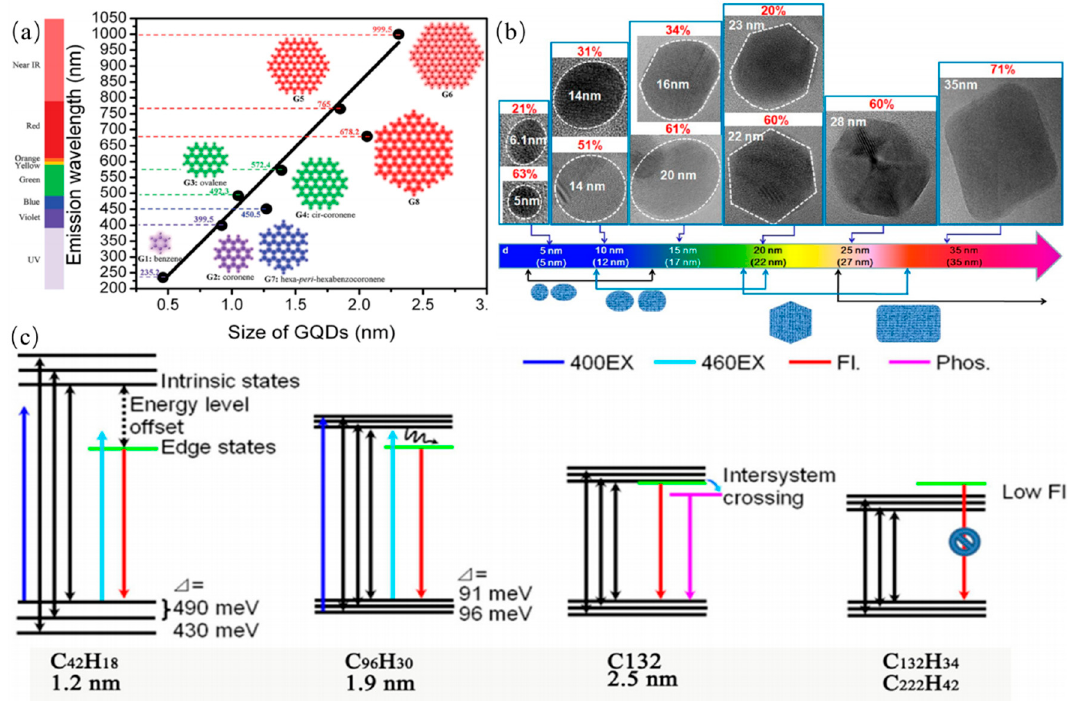
Figure 11. ( a ) Emission wavelength of GQDs with different sizes obtained through theoretical calculations [123]. Copyright 2014, Royal Society of Chemistry. ( b ) HRTEM images of GQDs for their major shapes and corresponding populations [124]. Copyright 2012, American Chemical Society. ( c ) The size-dependent energy levels in different H-passivated small GQDs [125]. Copyright 2014, Elsevier.